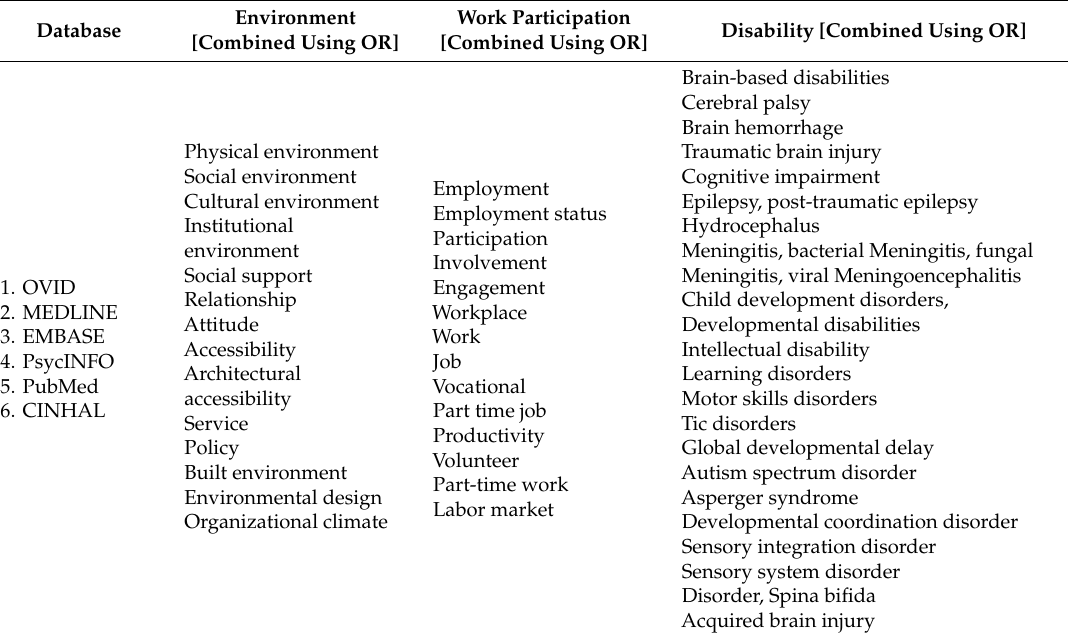
Table 1. Search terms